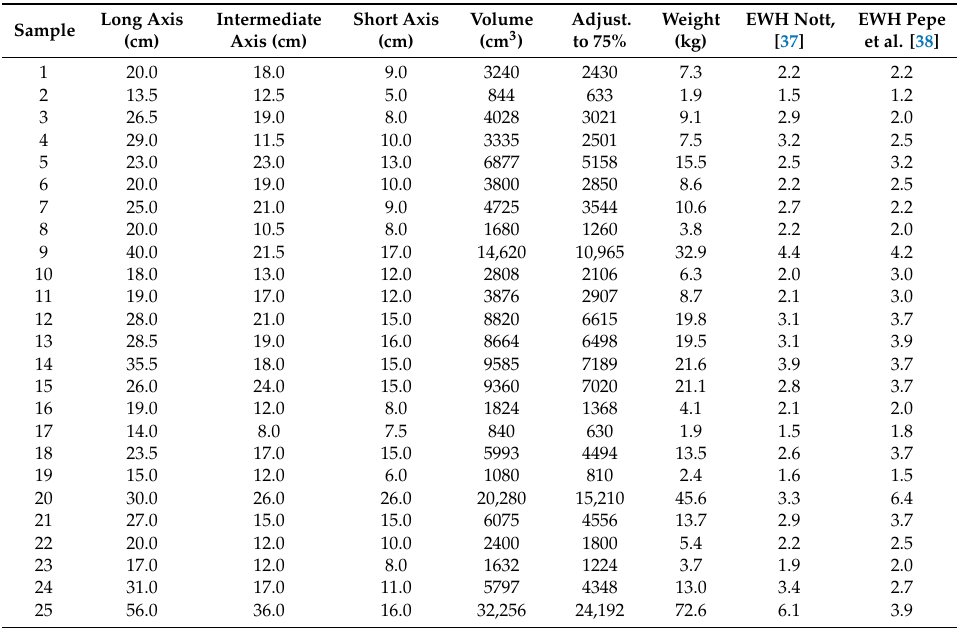
Table 6. Quantification of boulder size, volume, and estimated weight from the Pleistocene (MIS 5e) conglomerate at site 6 at Ponta do Cedro, on the east shore of Santa Maria Island (see map, Figure 1b, and field photo, Figure 9). The standard density of basalt at 3.0 gm / cm 3 was applied uniformly in order to calculate wave height for each boulder. EWH: estimated wave height (in meters), calculated from equations in Nott [37] and Pepe et al. [38]. See the methods Section 3.2. (hydraulic model). Long Axis Sample (cm)